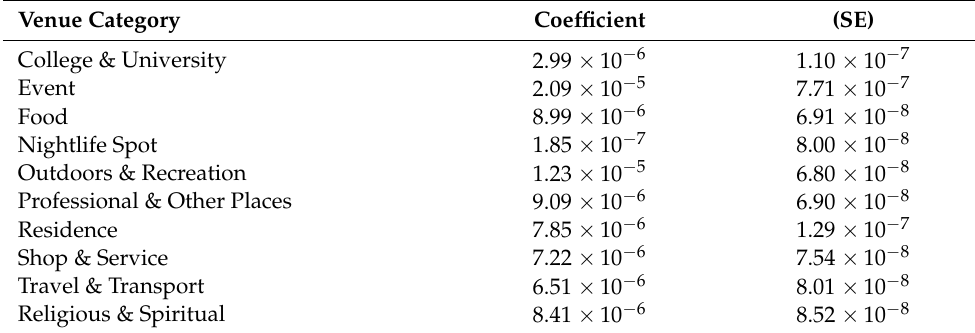
Table 1. Multinomial model with income as predictor.